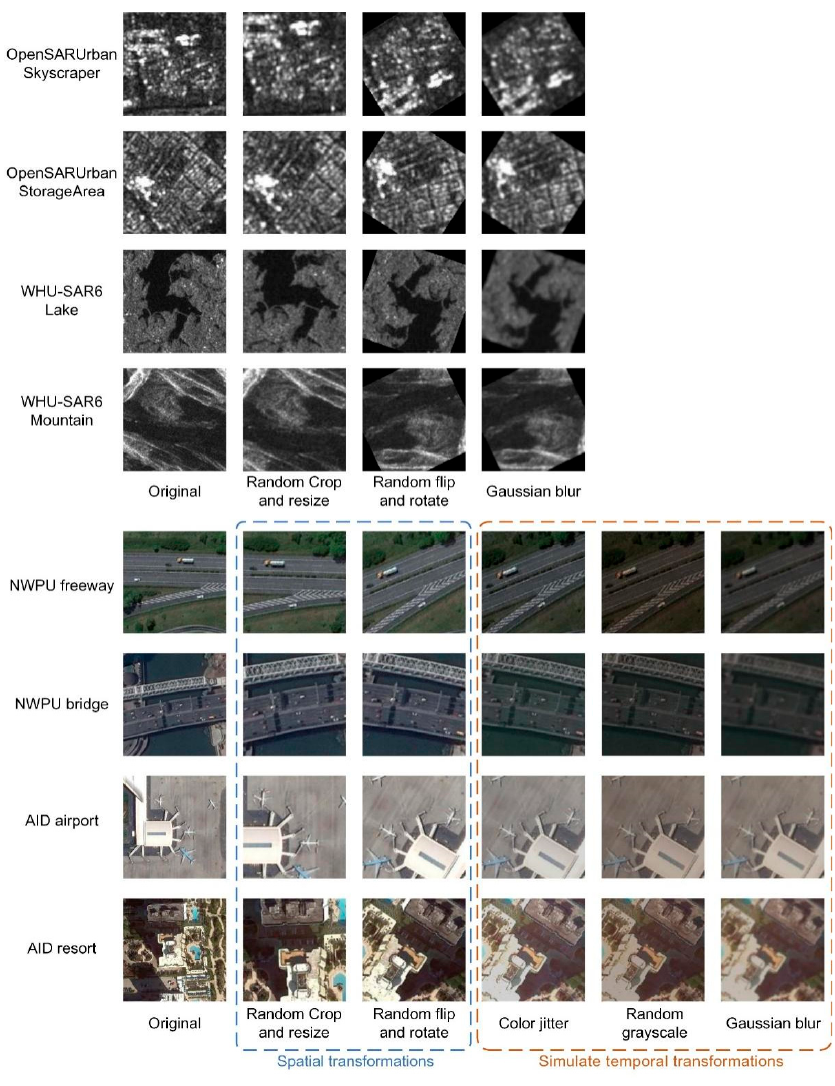
Figure 5. Illustration of data augmentations.